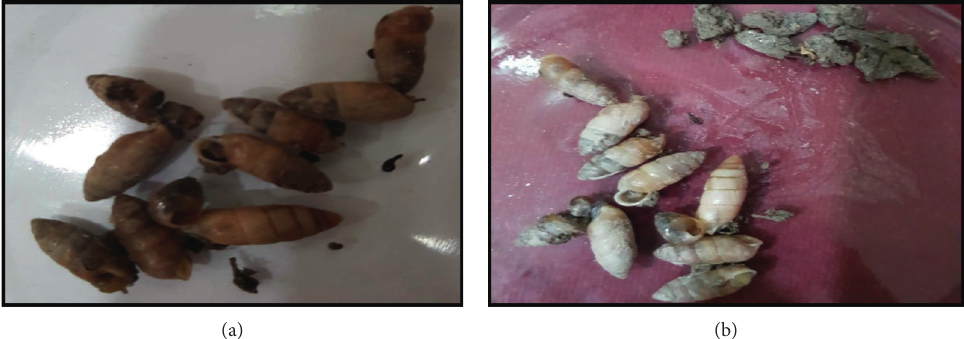
Figure 2: (a, b) Snails belonging to the genera Lymnaea collected during the study for the investigation of the prevalence of Para- mphistomum spp. cercariae (collection site: adjacent area of the river in district Charsadda).